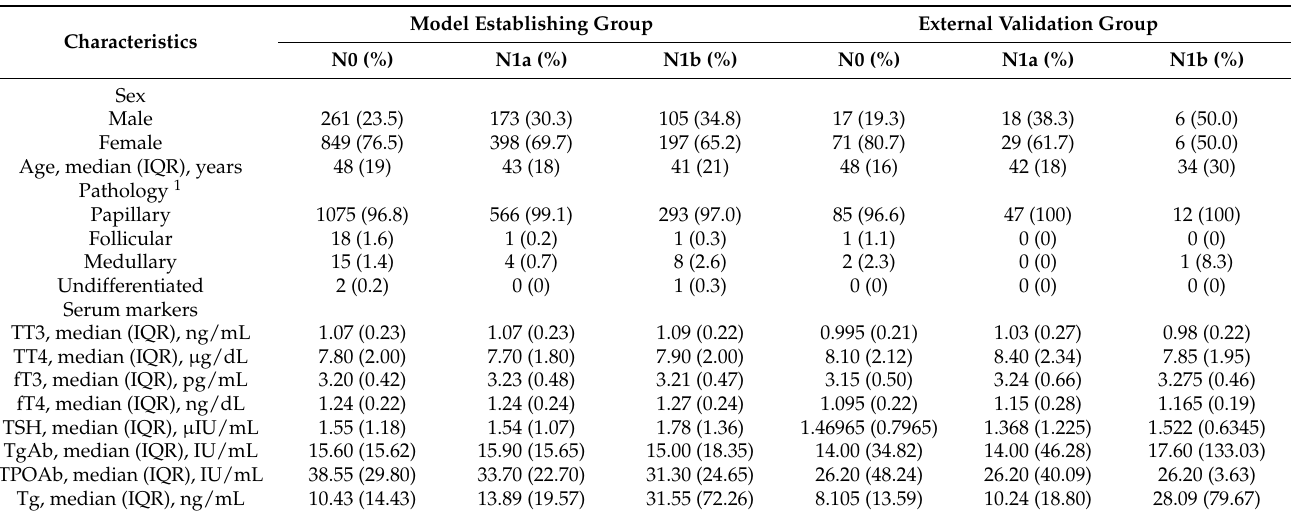
Table 1. Demographic and clinical characteristics of patients in the model establishing and external validation groups.